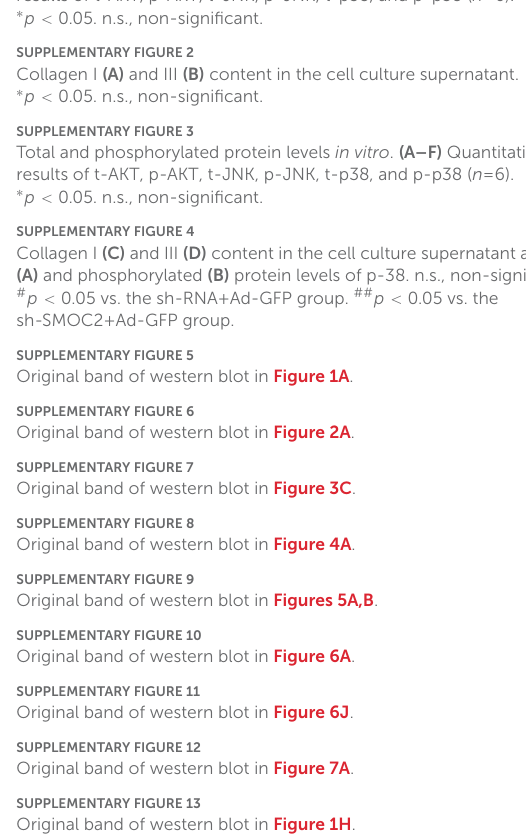
SUPPLEMENTARYFIGURE12 Original band of western blot in Figure 7A . SUPPLEMENTARYFIGURE13 Original band of western blot in Figure 1H